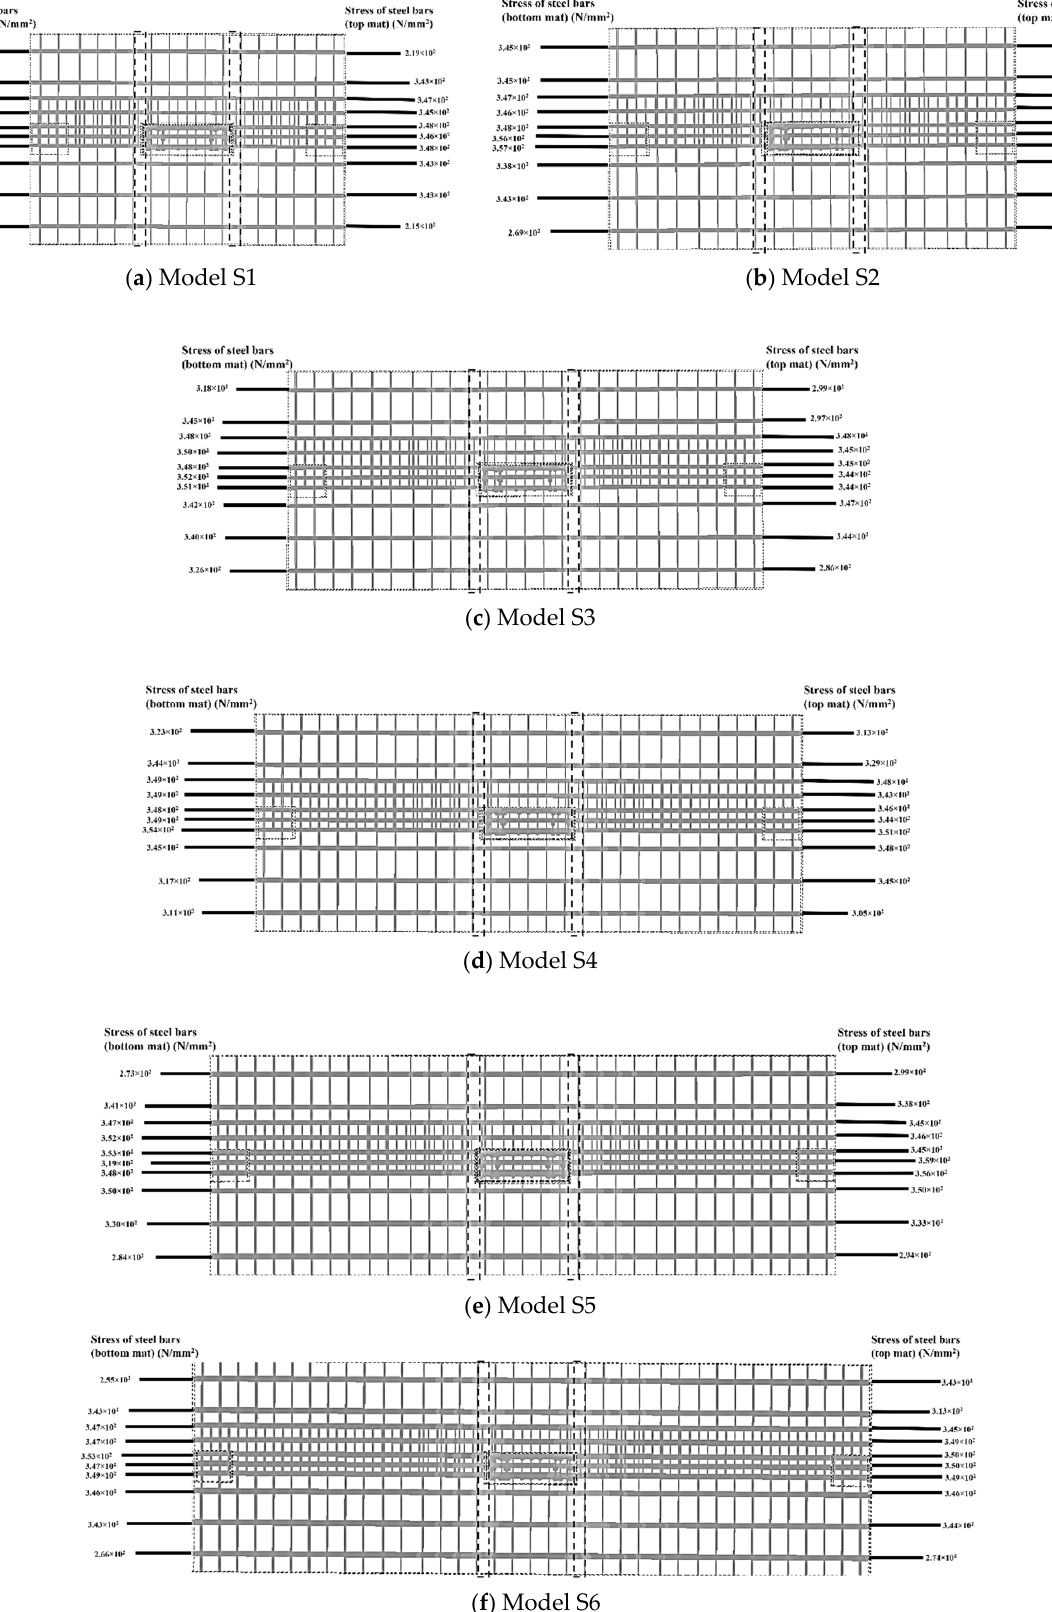
Figure 21. Stress and yield conditions for slab span length models.